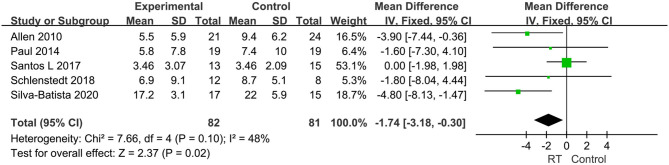
Forest plots of the effects of lower limb RT on gait performance—freezing of gait in PD. CI, confidence interval.